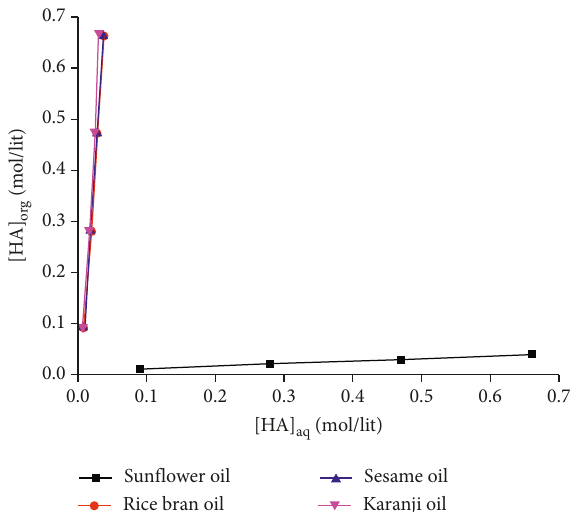
Figure 3: Reactive extraction equilibria for succinic acid using 30%